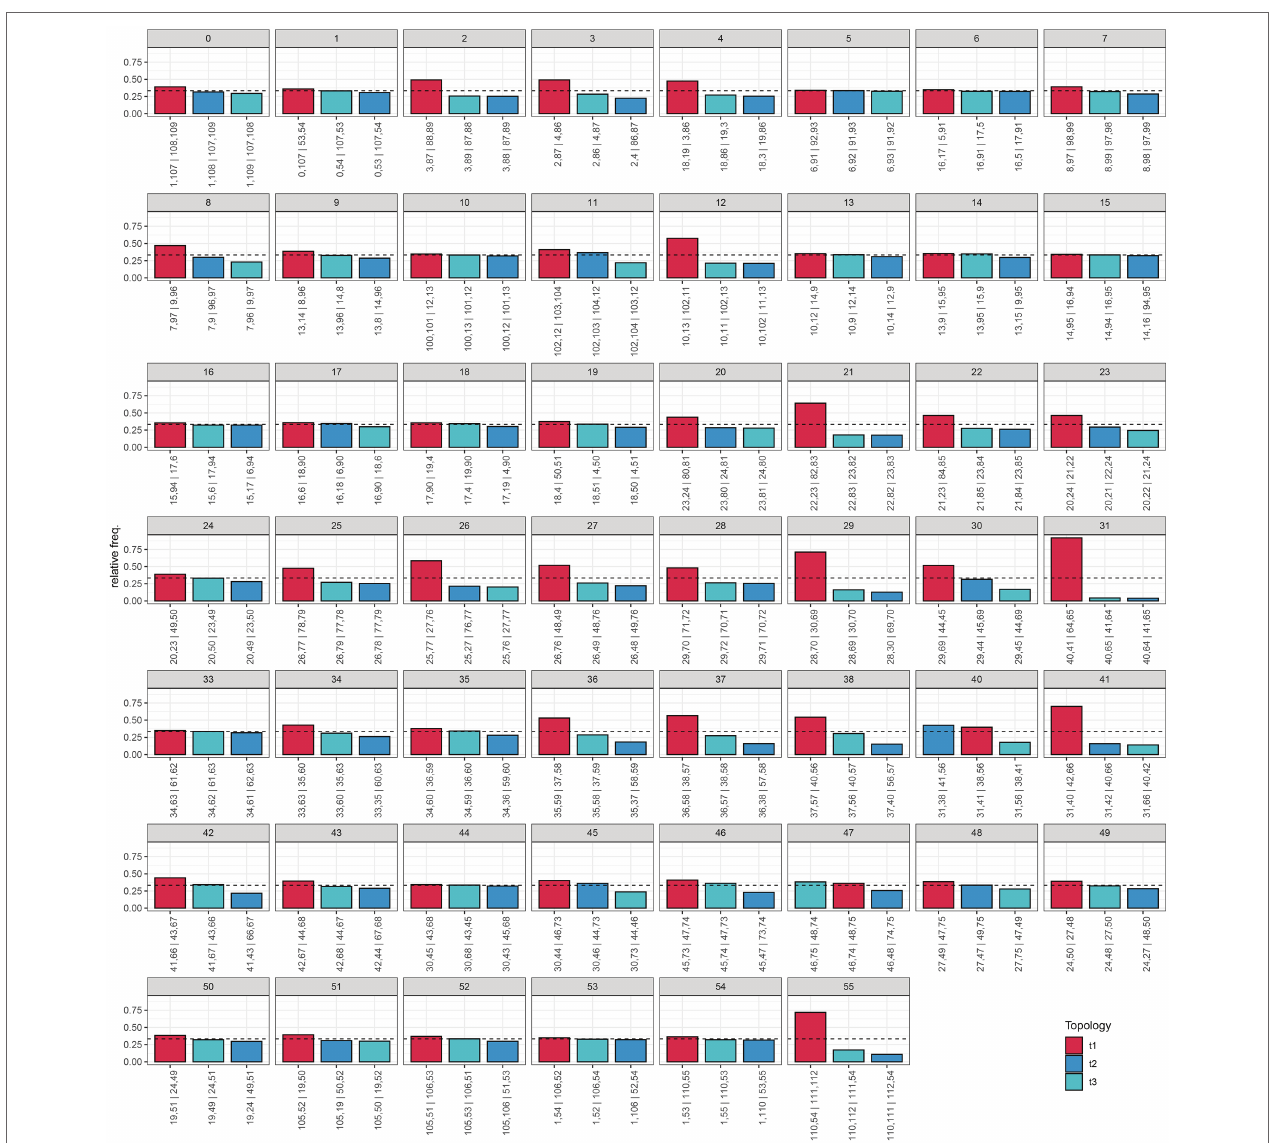
FIGURE 4 | Relative frequencies of alternative tree topologies for Euphrasia , computed with DiscoVista. Each bar graph represents potential for the three alternative branching relationships at each focal node labeled in the species tree presented in Figure 3 . Main topologies are in red, alternative topologies in blue, and the dotted line indicates a 1/3 threshold (equal representation of three topologies). The x-axis is labeled with neighboring branch labels (see Sayyari et al.,